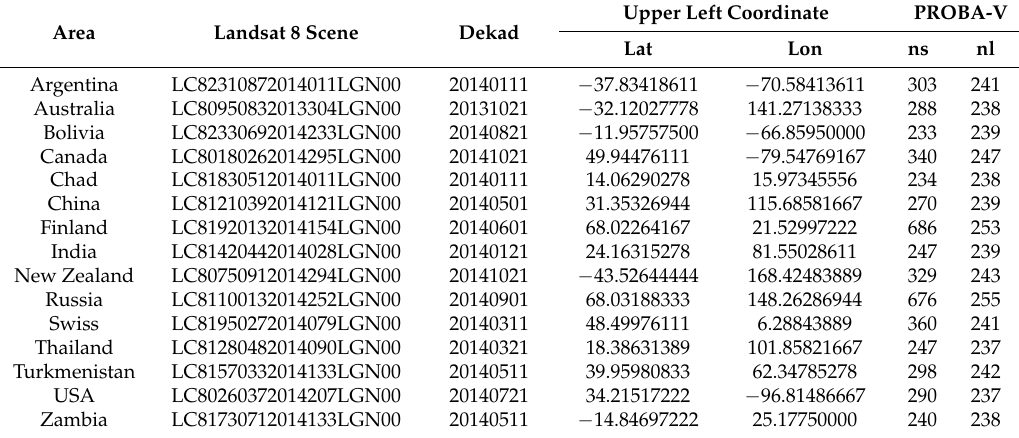
Table A3. Landsat 8 scenes of the 15 test regions selected worldwide were used to assess the water bodies detection algorithm. As much as possible, cloud free scenes were selected. The corresponding PROBA-V dekad and the upper left corner coordinate are given with the corresponding number of samples (ns) and lines